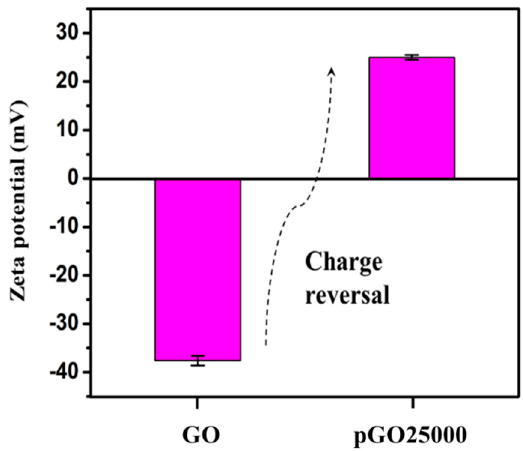
Figure 1. Charge analysis of GO and pGO25000.